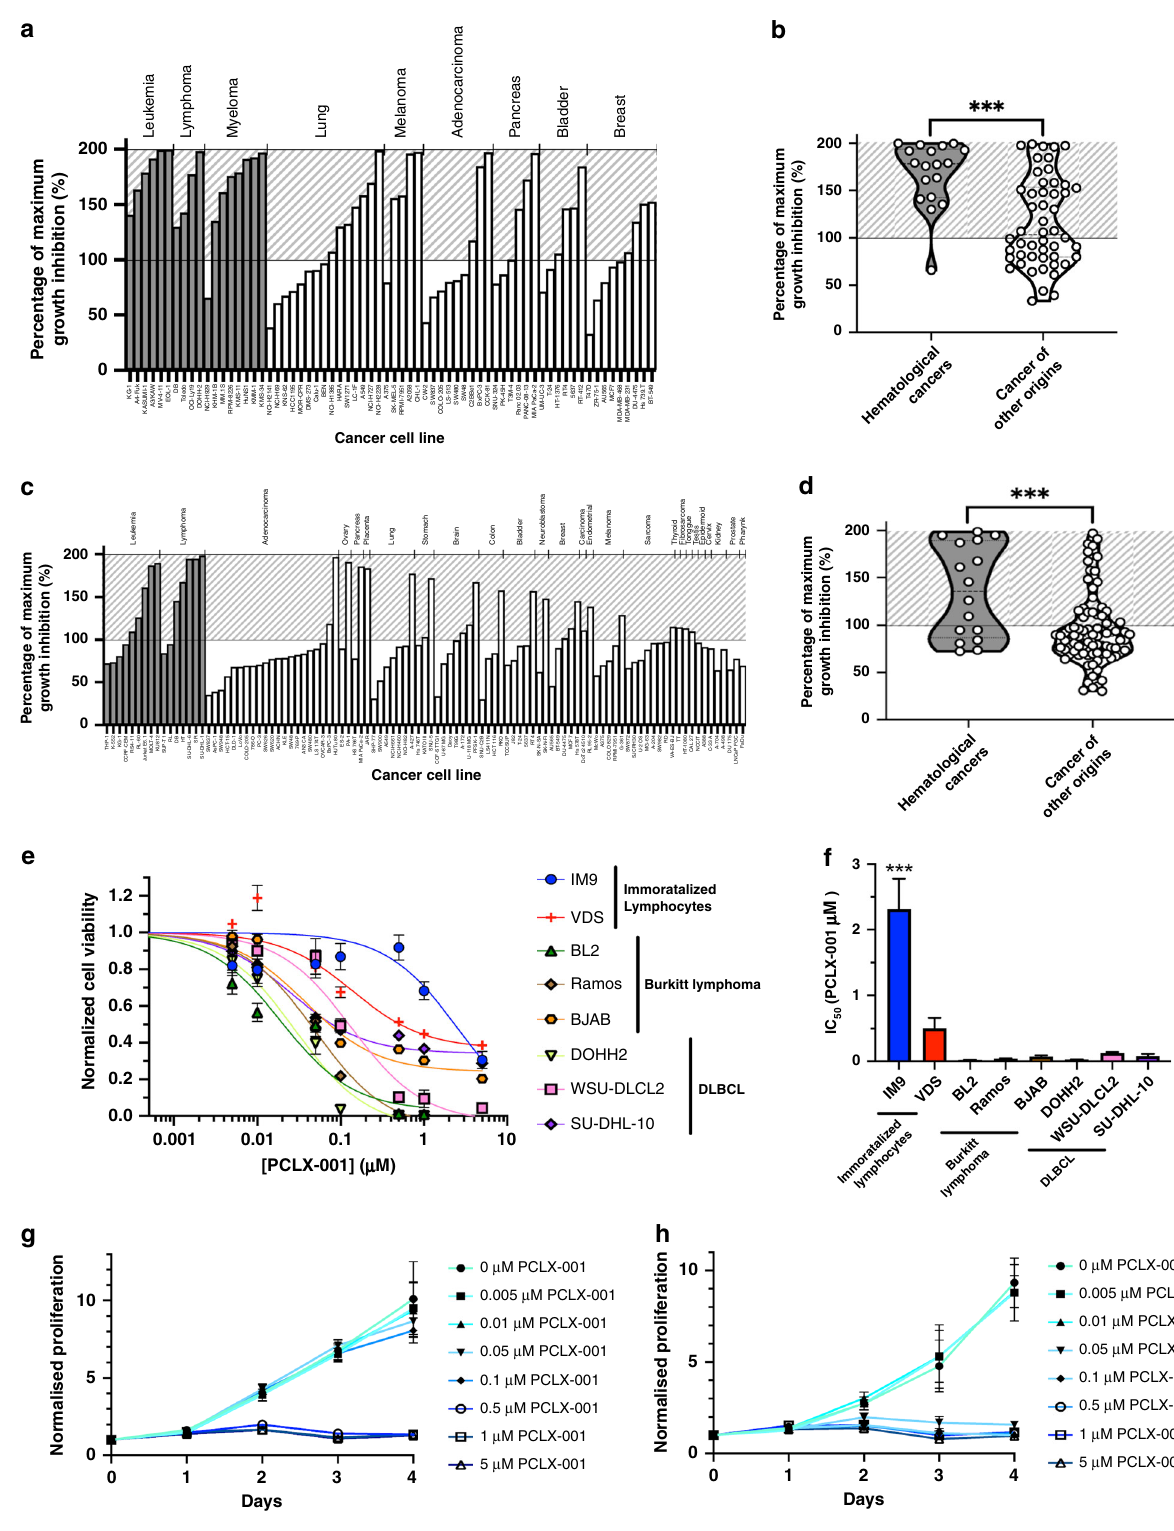
B-cells as measured by both CellTiter Blue (4 to 111 fold less PCLX-001 needed; Fig. 1e, f) and Calcein (2 to 40 fold less PCLX- 001 needed; Supplementary Fig. 3) assays. PCLX-001 is also better at inhibiting the proliferation and viability of the six malignant B-lymphoma cell lines in comparison to benign IM9 and VDS B- cells (Fig. 1e – h, Supplementary Figs. S3 and S4). To illustrate this, we show the treatment of malignant BL2 cells with 0.05 and